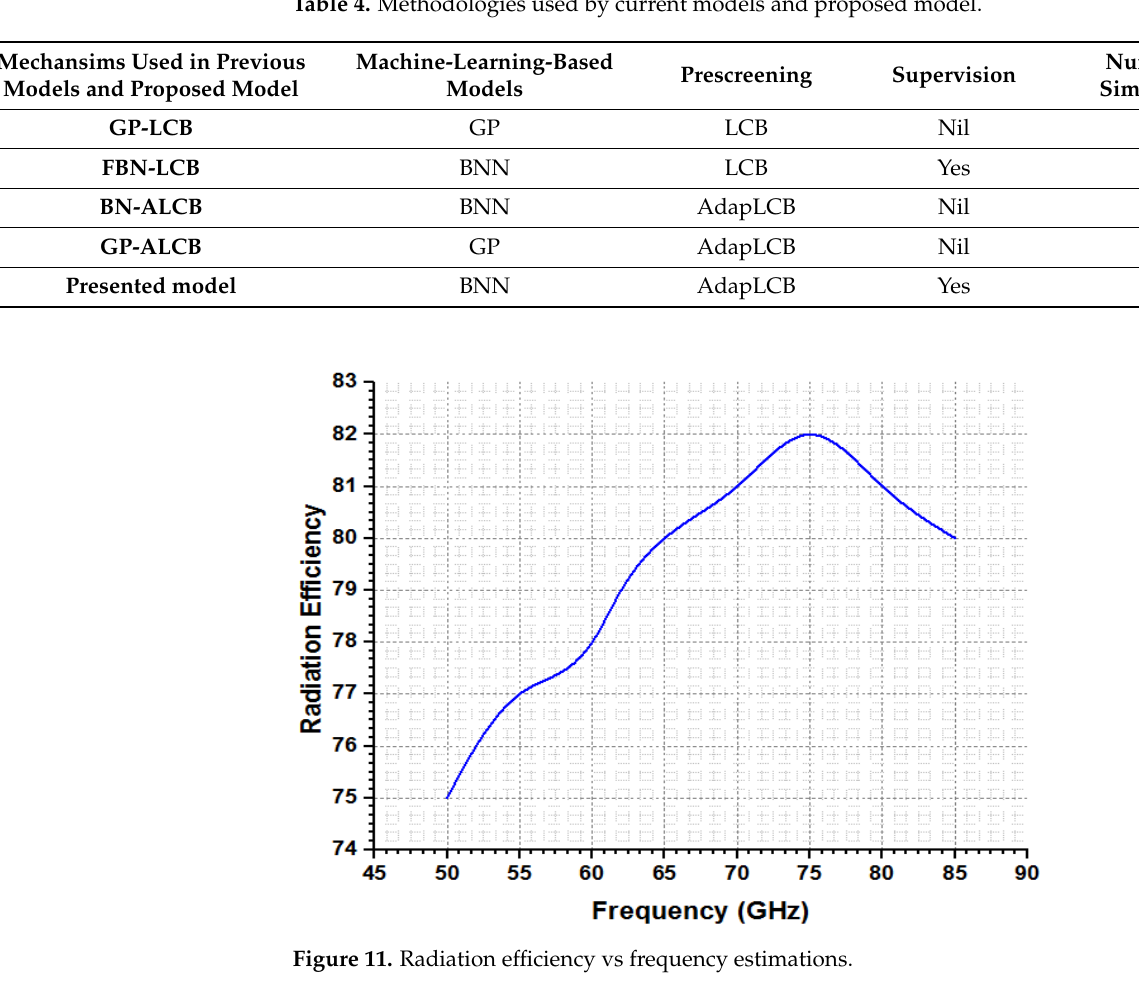
Table 4. Methodologies used by current models and proposed model.